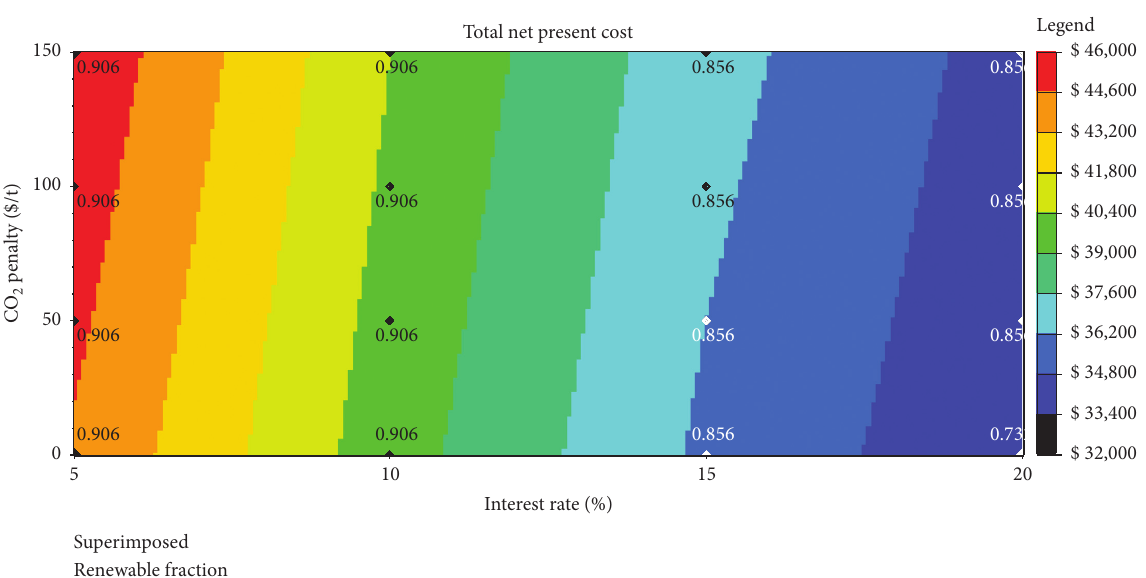
Figure 13: Surface plot of total